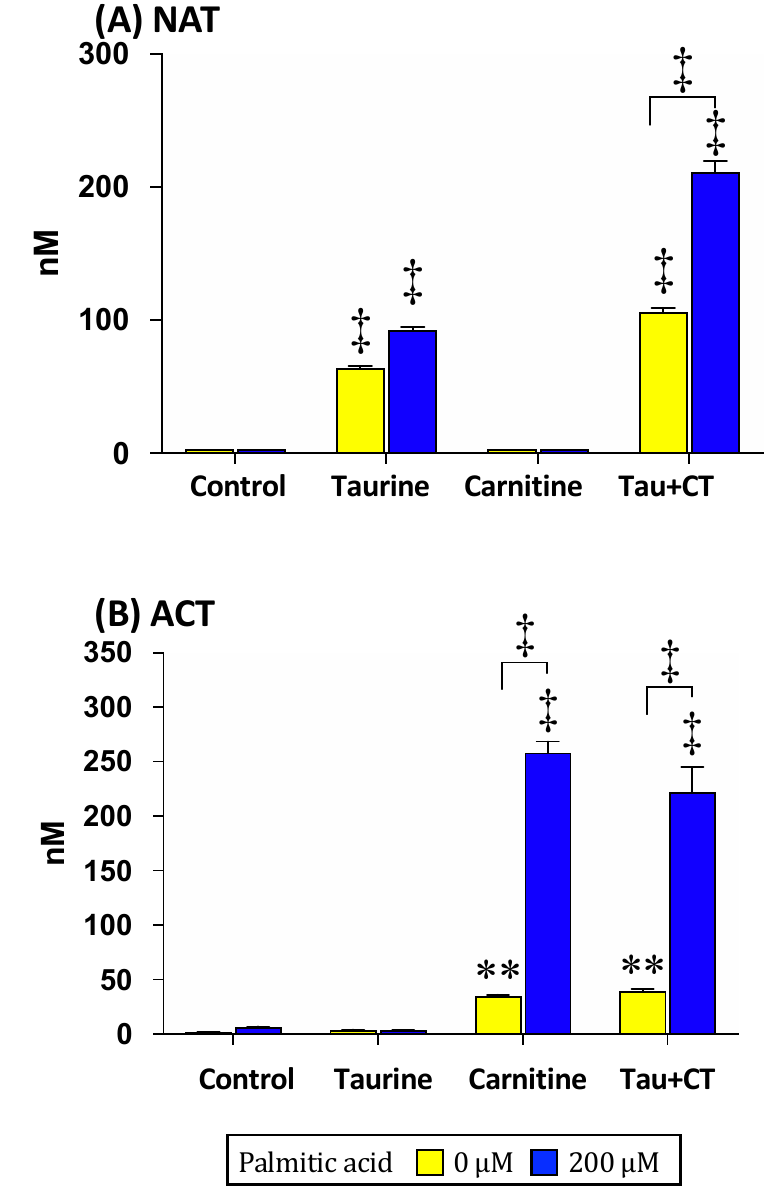
Figure 4. NAT and ACT concentrations in the culture medium of the myotube after exposure to palmitic acid combined with taurine and/or carnitine. The myotube was treated with 20 mM taurine or/and 300 µM carnitine for 24 h. Then, it was exposed to 200 µM palmitic acid for 24 h. NAT ( A ) and ACT ( B ) concentrations in the culture medium were measured. The data shown refer to the mean ± SEM. ** p < 0.01 and ‡ p < 0.0001 show the significant differences analyzed by the two-way ANOVA multiple comparison test. The symbols on the columns without bars show the significant difference compared to those in the non-pretreated control and taurine pretreated with palmitic acid. Abbreviations: NAT; N -acetyltaurine, ACT; acetylcarnitine, Tau+CT; taurine and carnitine.